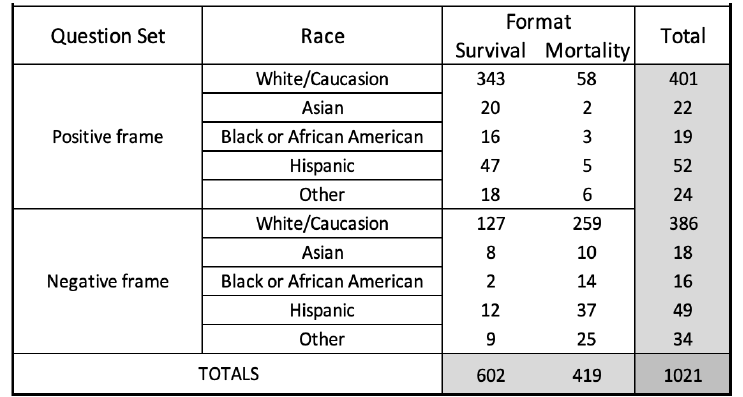
Figure 4. Respondent totals by